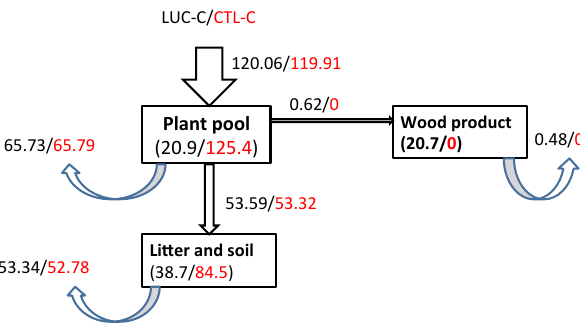
Fig. 4. Mean annual flux into different pools (the numbers beside the arrows, PgC yr − 1 ) and change in pool sizes (PgC) from 1850 to 2005 for C-only simulation with LULCC (black numbers) or with- out LULCC (red numbers).